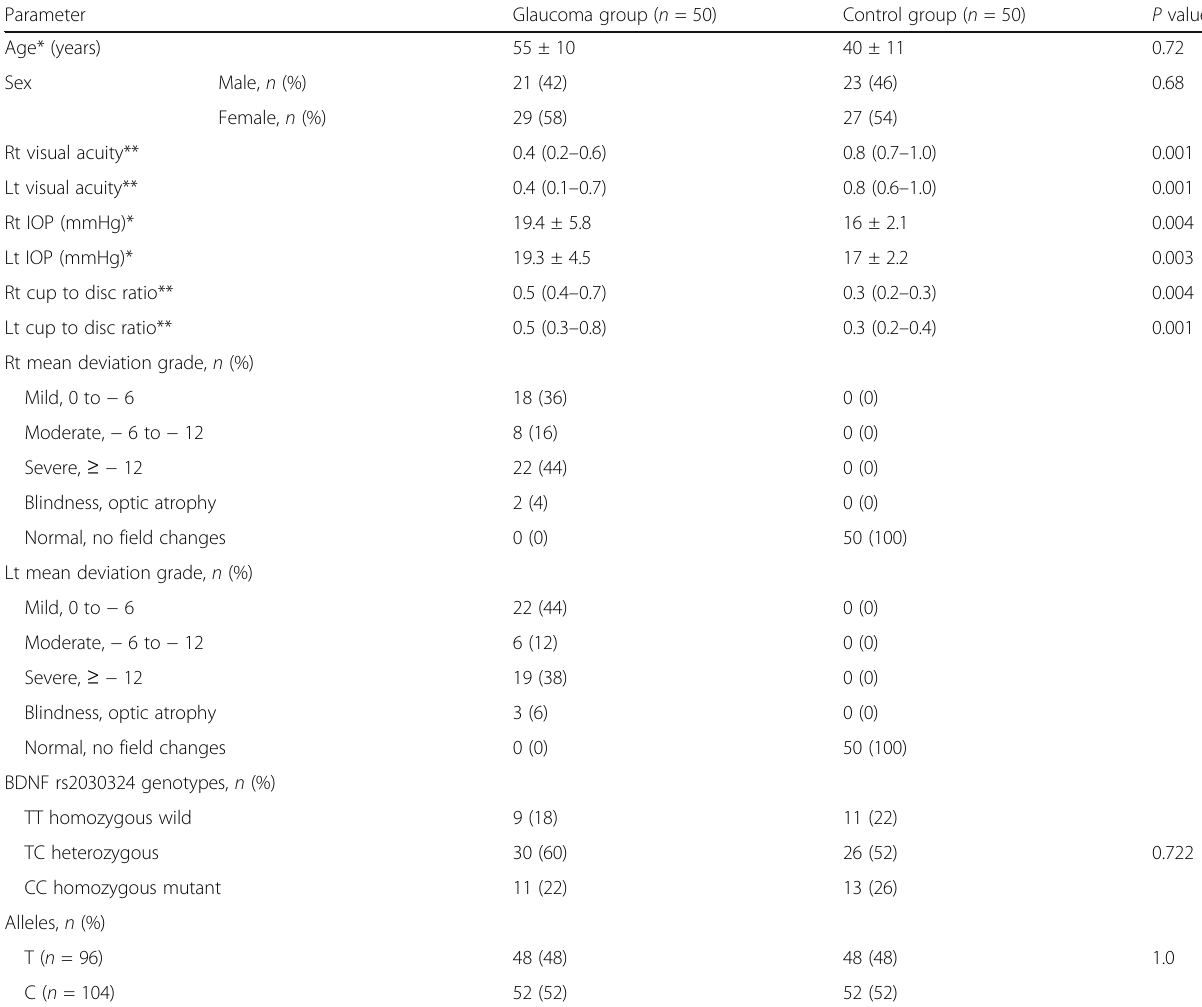
Table 1 Demographic, ocular parameters, and genotyping of the two studied groups Parameter Glaucoma group ( n =